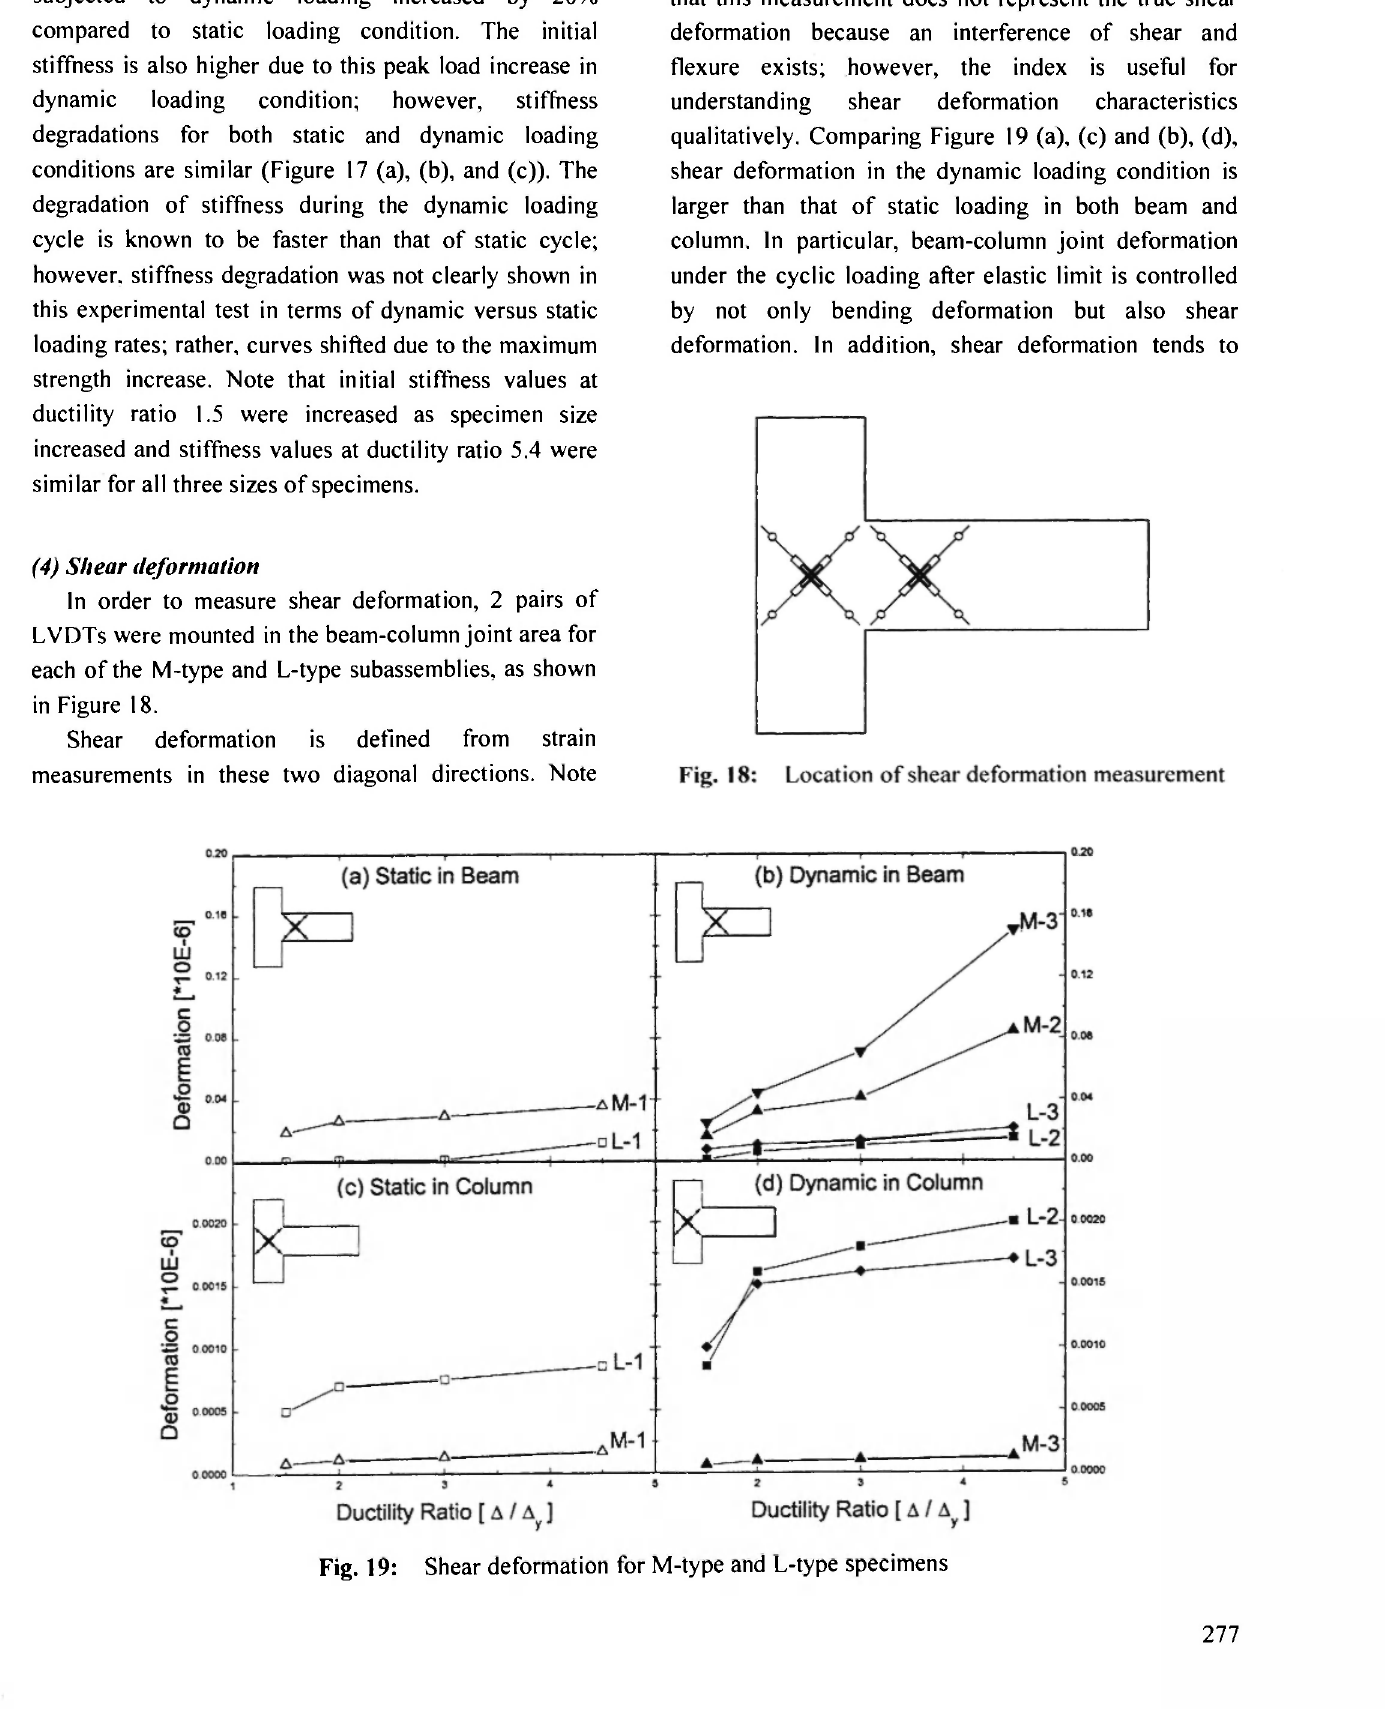
Fig. 19: Shear deformation for M-type and L-type